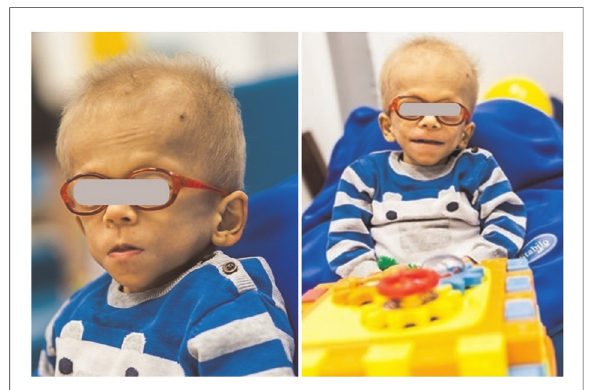
FIGURE 1 Phenotypical features of the patient with CFCS type 3 due to a